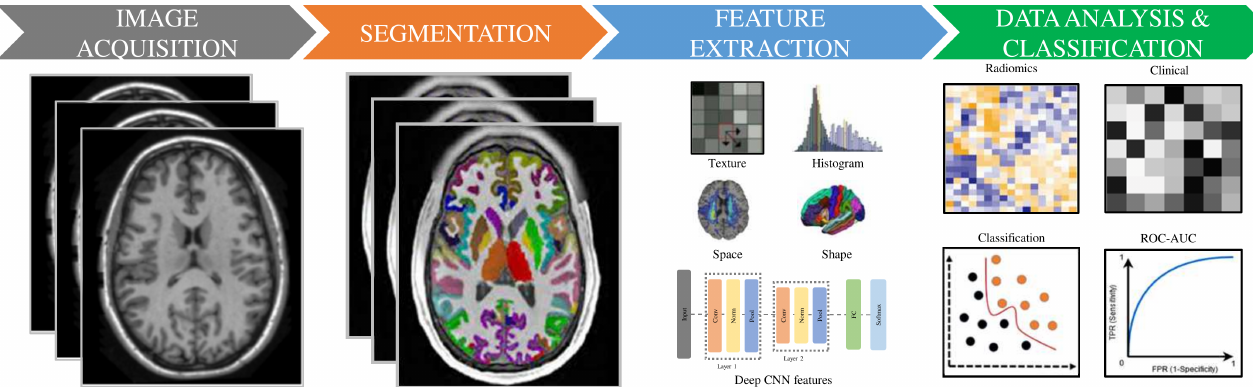
Figure 1. General radiomic workflow for predicting ASD. Schematic illustration of the entire radiomic process, including image acquisition with preprocessing with symptomatic ASD patients undergoing MR (MRI and/or fMRI) scans. After image segmentation, radiomic features are extracted and selected. Data aggregation for statistical modeling, with classifier modeling employed for classifying ASD from